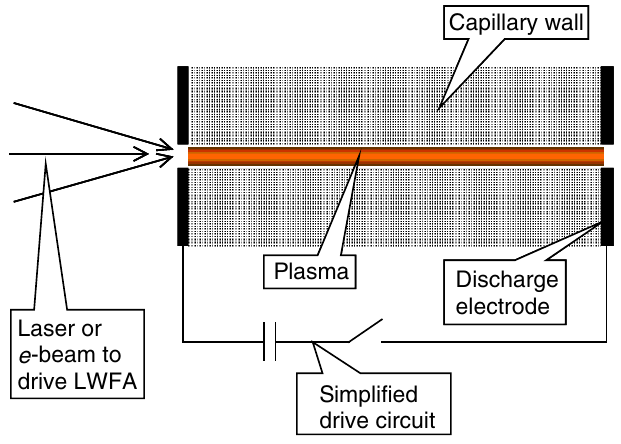
FIG. 1. (Color) Side-view schematic of typical capillary dis- charge for either LWFA or PWFA